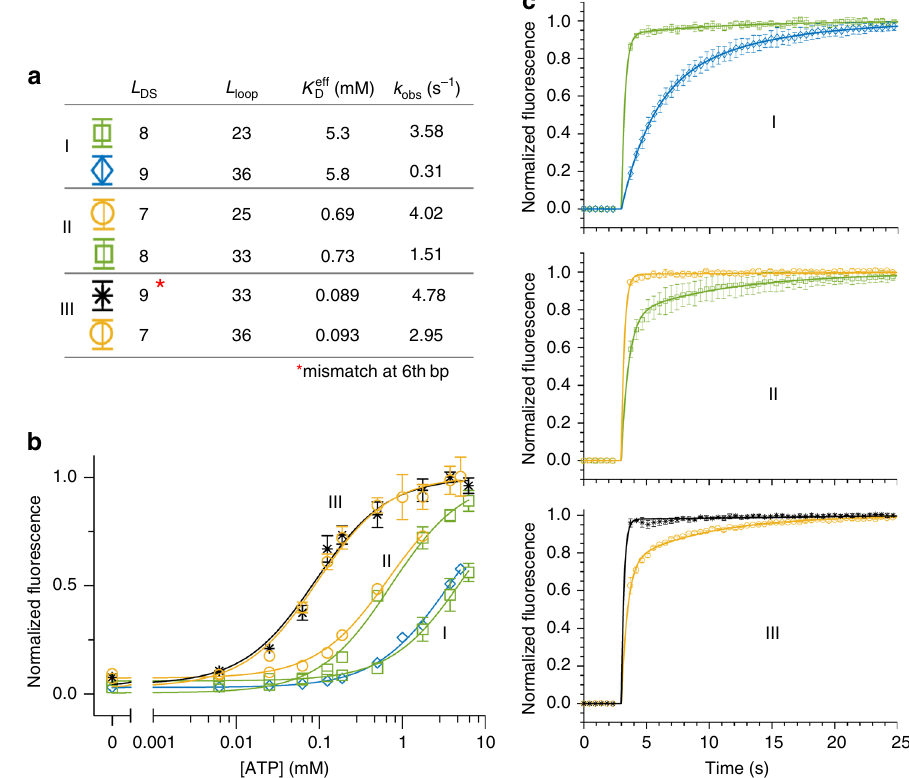
Fig. 5 Independent tuning of kinetics and thermodynamics. Simultaneously increasing both L DS and L loop has synergistic effects on temporal resolution but opposing effects on K eff . Therefore, it should be possible to change the kinetic response of the switches while holding the af fi nity constant. a We con fi rmed D this by examining three pairs (I, II, III) of ISD constructs. b Each pair exhibited nearly identical binding curves, c but has been engineered in terms of L DS and L K eff listed in a and the binding curve fi ts in b are respectively calculated from and normalized to a loop to exhibit vastly different kinetic responses. The D single-site hyperbolic binding curve. For kinetics measurements, pair I was run at [ATP] = 2.5 mM and pairs II and III were run at [ATP] = 1 mM. Plots were averaged over three replicates ( n = 3) and error bars represent the standard deviation. Source data are provided as a Source Data fi le